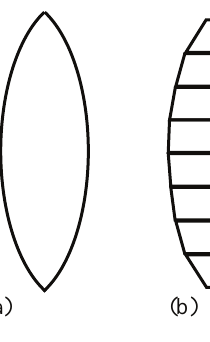
and y re- 1 2 and p . In particular a ray paral- 1 2